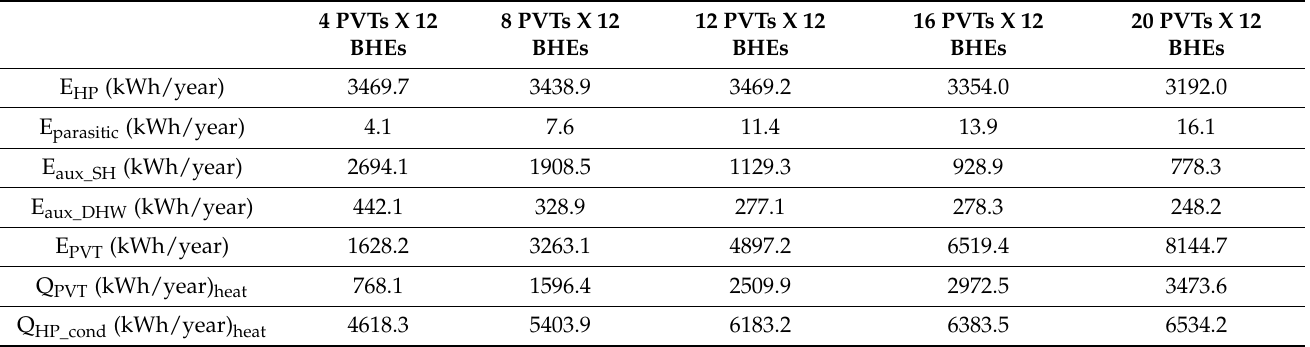
Table 7. Annual electric energy (E) consumed on the SAGSHP system and the annual electricity and heat produced by the PVTs, along with the heat provided by the heat pump for Ottawa. 4 PVTs X